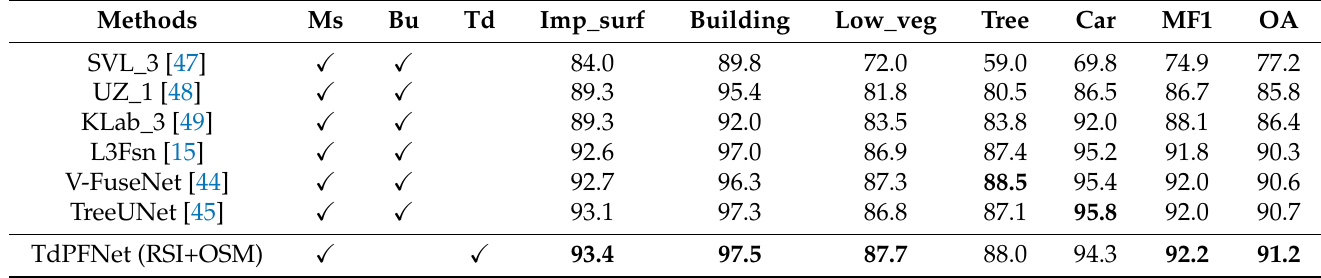
Table 3. Detailed performance comparisons with the-state-of-the-art models on Potsdam test set. The number in bold is the maximum value. All percentage signs are omitted. Ms: Multi-source. Bu: Bottom-up. Td: Top-down. Methods